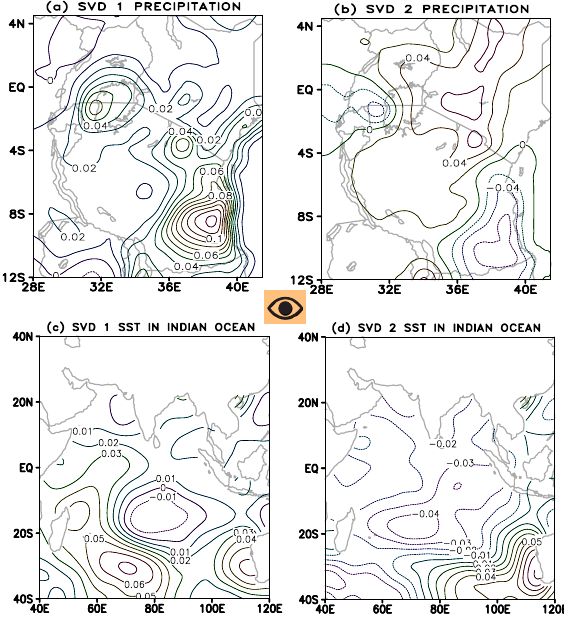
Figure 3. The homogeneous map of the first two modes of SVD for the Precipitation (mm/month) (a and b) and SST (°C) in an Indian Ocean (c and d)